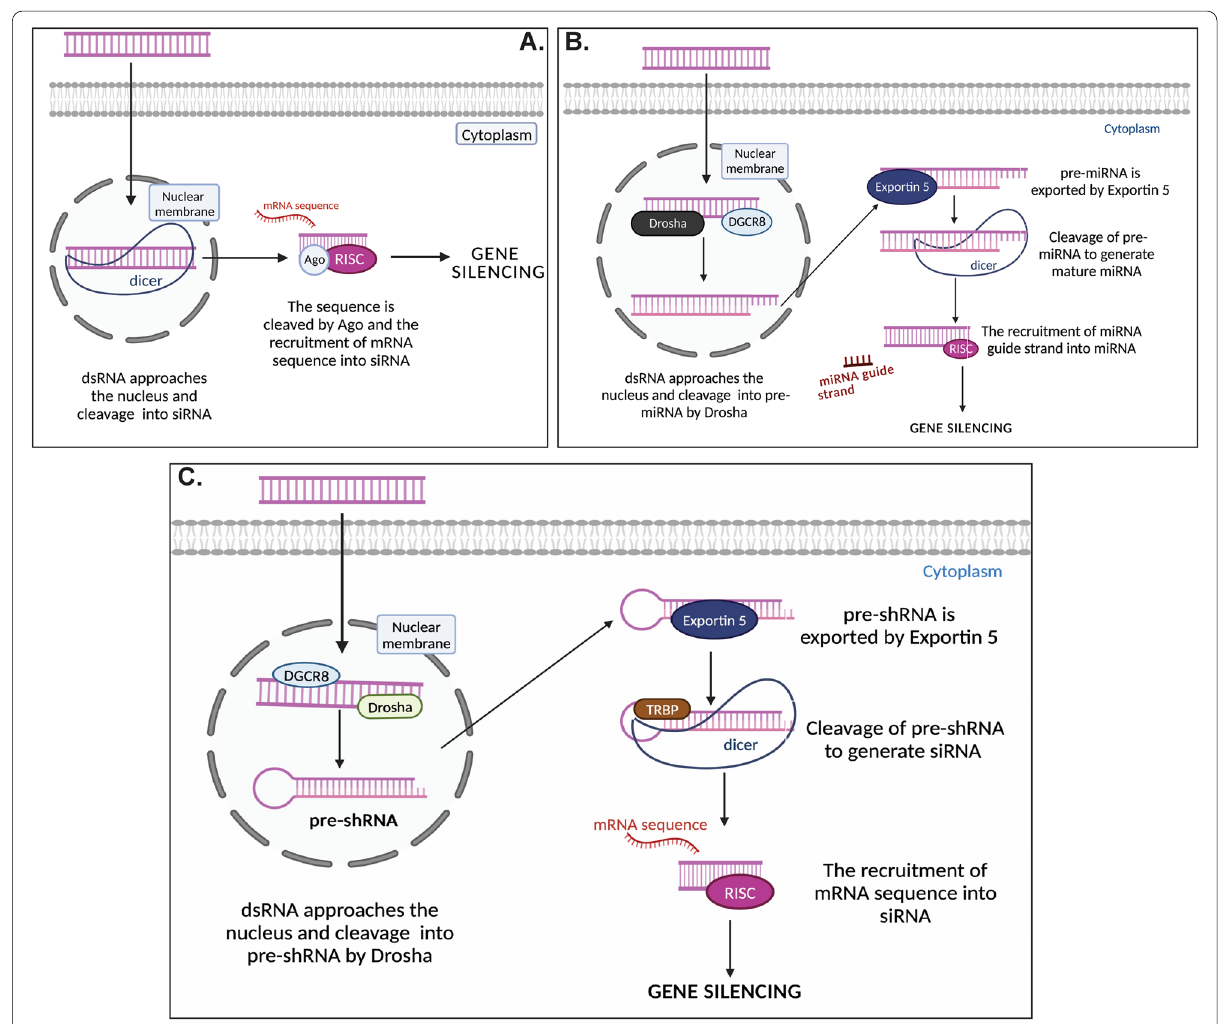
Fig. 3 Biogenesis of RNA Interferences. A Biogenesis of siRNA. dsRNA of the pathogen approaches the nucleus, where it is cleaved into si-RNA. In the cytoplasm, siRNA is loaded onto RISC and undergoes cleaving by Ago protein. Then, mRNA complementary to the siRNA binds to it, leading to gene silencing. B Biogenesis of miRNA. Genetic material (dsRNA or pri-miRNA) of the pathogen approaches the nucleus, where it is cleaved by DROSHA in combination with DGCR8 into pre-miRNA. In the cytoplasm, the pre-miRNA is cleaved by DICER to form mature mi-RNA. Thereafter, it is loaded onto a RISC, where it binds to a complementary mRNA strand to allow gene silencing. C Biogenesis of shRNA. Inside the cell, dsRNA of the pathogen approaches the nucleus, where it is processed by DROSHA in combination with DGCR8 and forms pre-shRNA. In the cytoplasm, DICER in complex with TRBP cleaves pre-shRNA to siRNA. It is then loaded onto a RISC, which it binds to a complementary mRNA strand to allow gene silencing. dsRNA, double-stranded RNA; siRNA, small interfering RNA; RISC, RNA-induced silencing complex; Ago, Argonaute; mRNA, messenger RNA; pri-miRNA, primary microRNA; DGCR8, DiGeorge syndrome critical region 8; pre-miRNA, precursor miRNA; pre-shRNA, precursor Short hairpin RNA; TRBP, transactivation response element RNA-binding